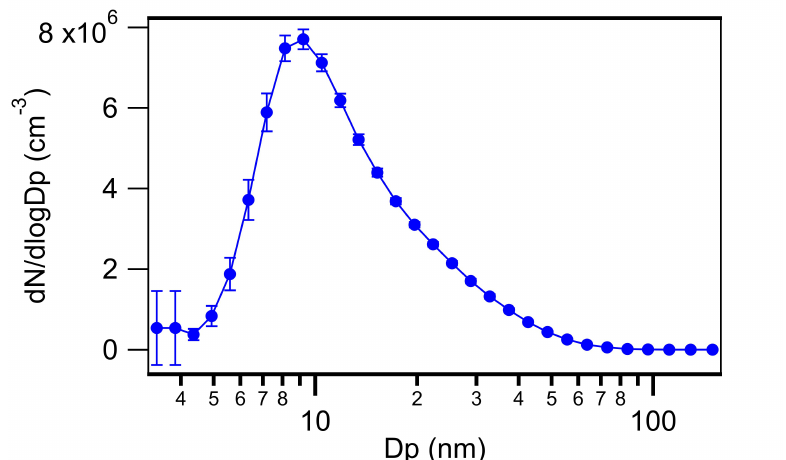
Figure 7. SA–TMAO particle number-size distribution averaged over 24 h, with error bars indicating standard